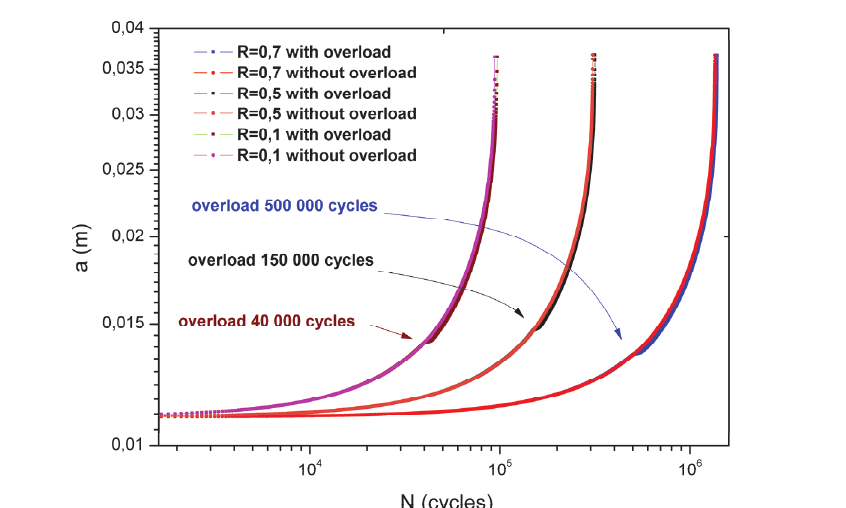
Figure 3: Crack propagation evolution before and after application of the overload for the different load ratios.